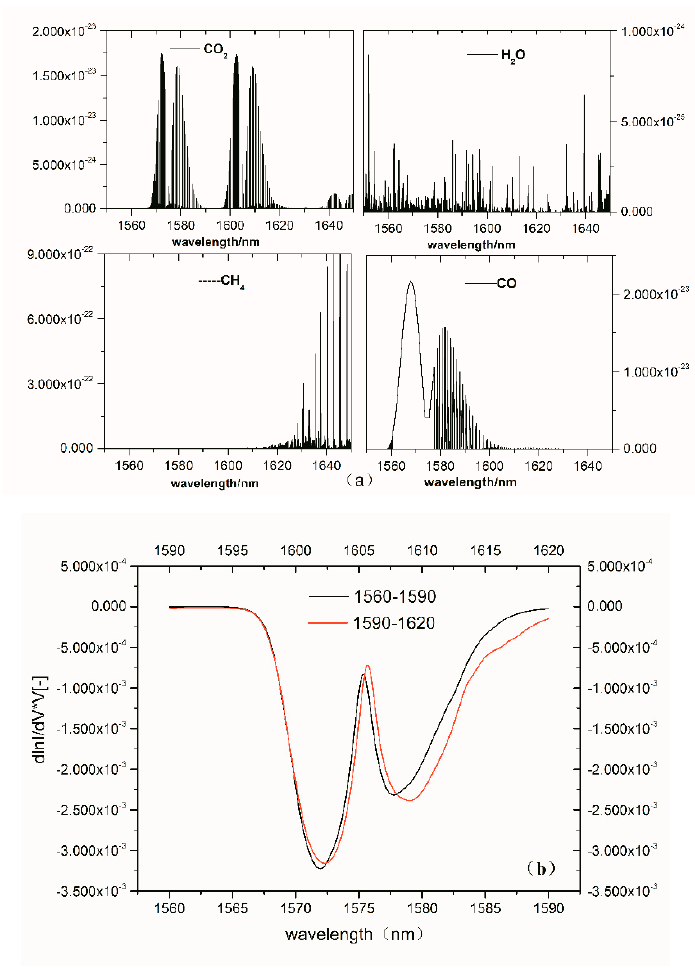
Figure 3. ( a ) Absorption characteristics of CO 2 , H 2 O, CH 4 , and CO at 1550–1620 nm and ( b ) CO 2 CWF in two bands.